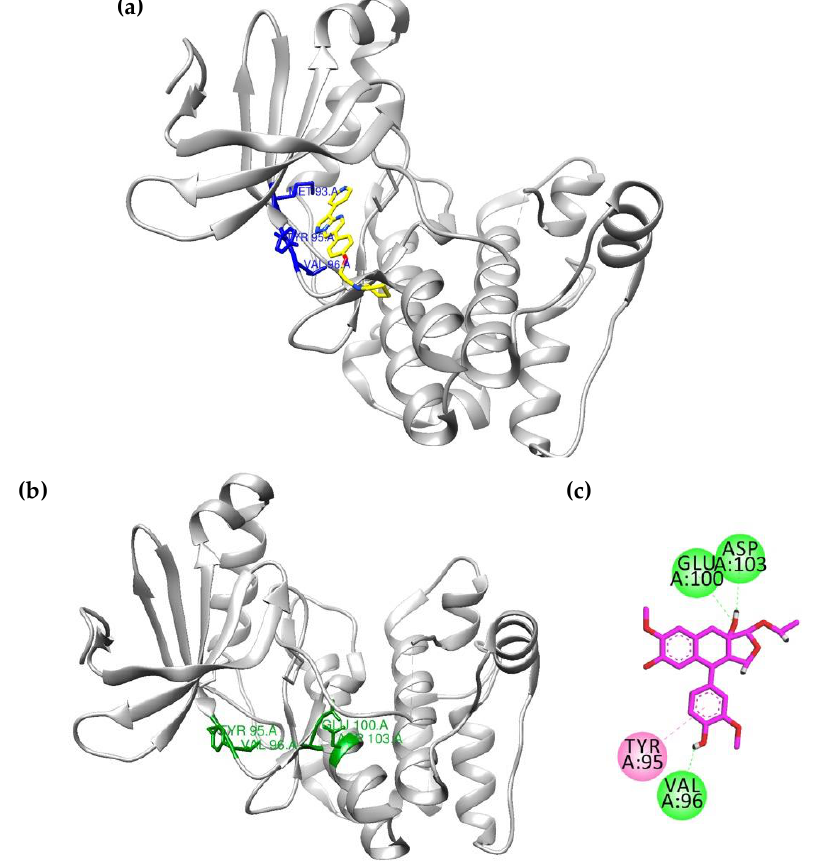
Figure 5. Predicted interaction pattern, in terms of involved residues, for ( a ) the native ligand and ( b ) ferruginan in the binding site of AMPK. The involved residues are highlighted, and the amino acids targeted by ferruginan are also reported in panel ( c ).